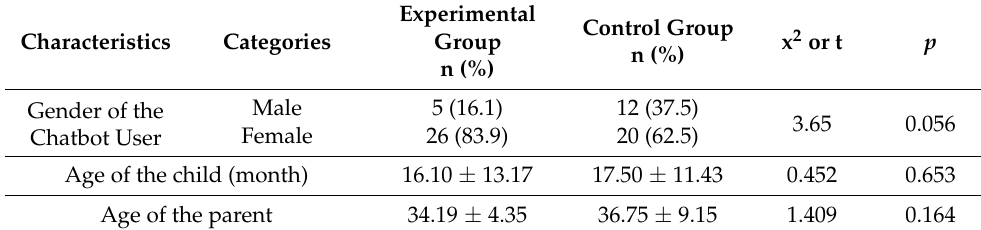
Table 5. Homogeneity test of general characteristics at baseline.